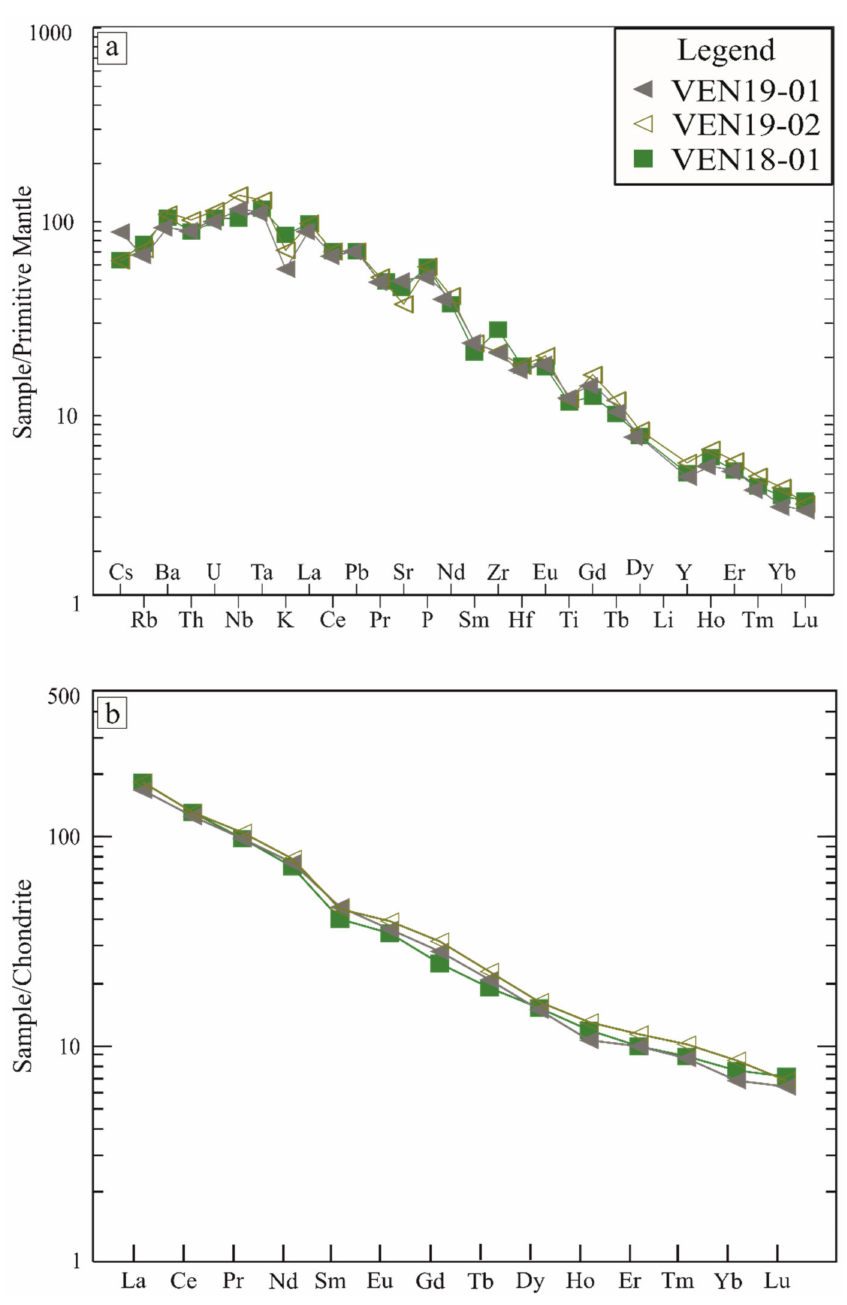
Figure 11. ( a ) Primitive mantle normalised spider diagram [23], for the Castelletto and Tonezza del Cimone rocks; ( b ) chondrite normalised REE patterns